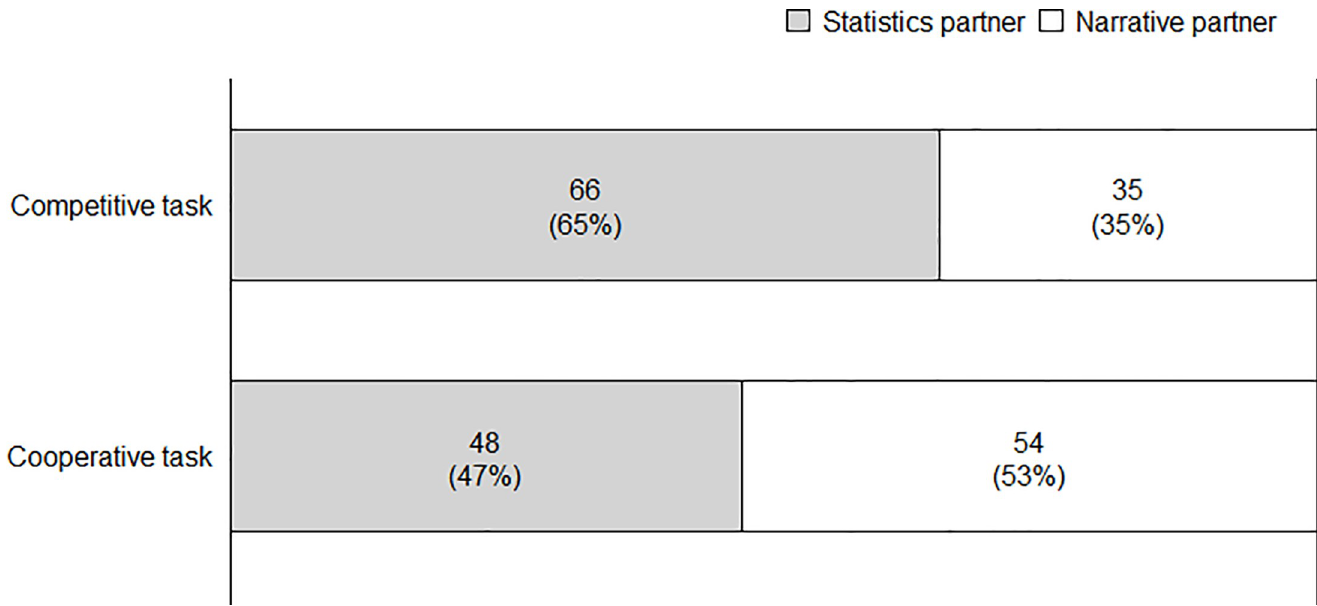
Fig 3. Partner choice (shown as percentage) by task assignment in Study